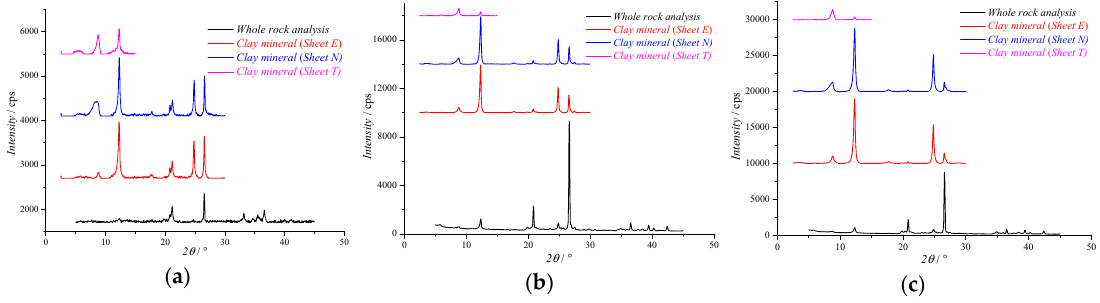
Figure 11. XRD diffraction, pattern . ( a ) Mudstone, ( b ) sandstone, ( c ) sandy mudstone.